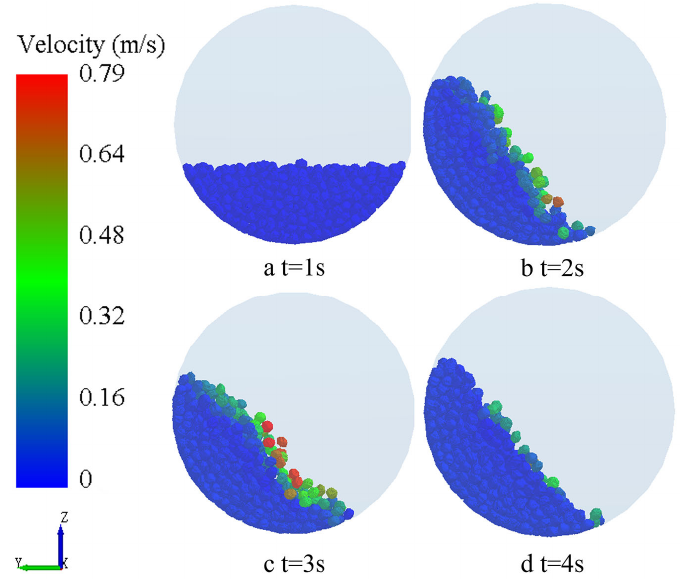
Figure 21. Snapshots of the simulation of the rotating hub test of Jinong 1 seeds using the 188-sphere model.